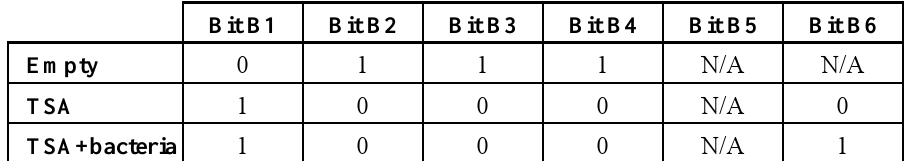
Table 1. The logic input of the Boolean logic circuit generated from Figure 10. Zero stands for σ = − 1 and 1 stands for σ n